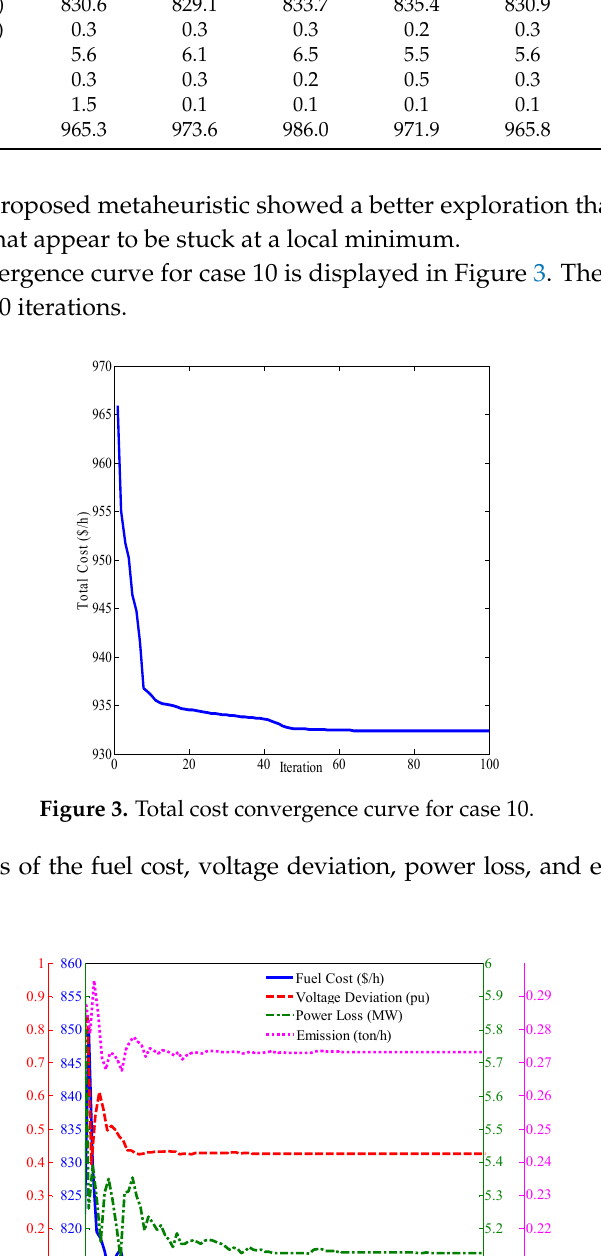
Figure 4. Total cost components convergence curves for case 10.